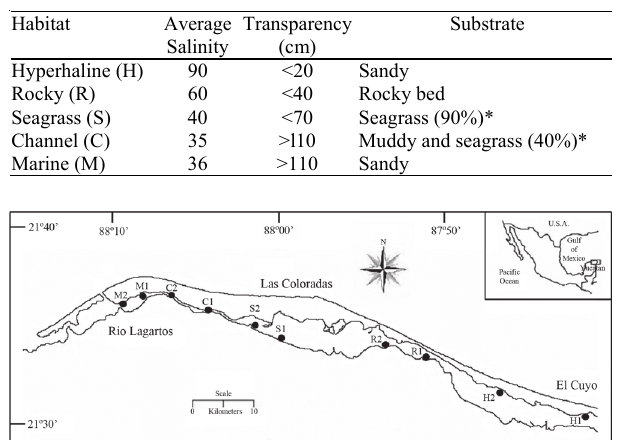
Fig. 1. Study area showing the Ría Lagartos Lagoon system, Mexico and sampling stations. Letters show different types of habitats and numbers are replicas in the same habitat. (hyperhaline: H, rocky: R, seagrass: S, channel: C, and marine: M).